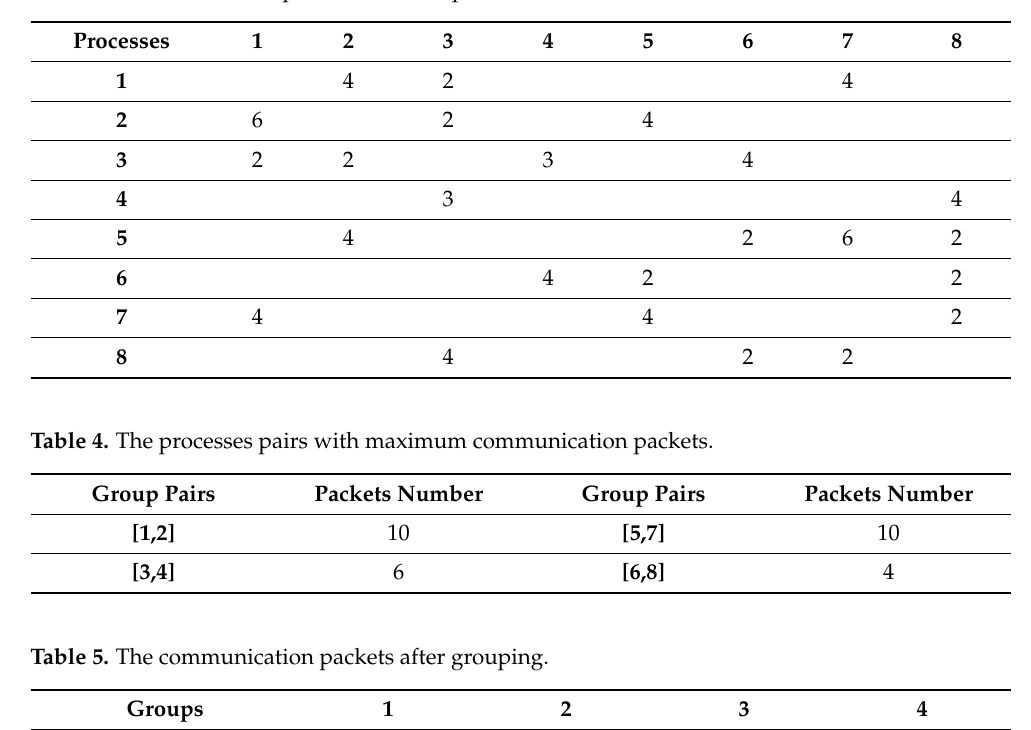
Table 3. Communication packets between processes.